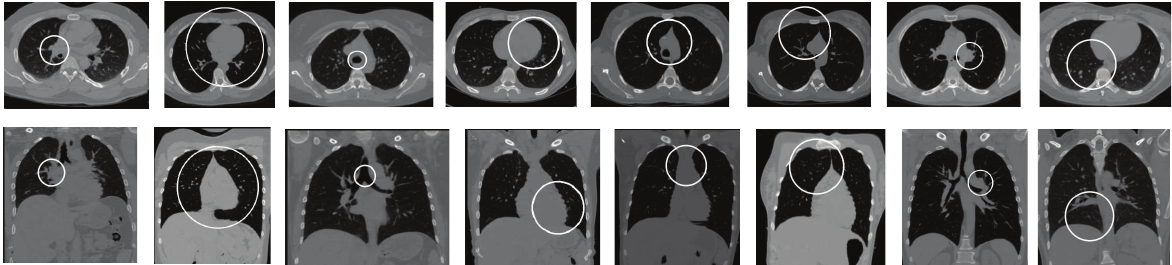
Figure 2: Example of representative lung features 𝜌 r . Each column shows a single feature in axial and frontal